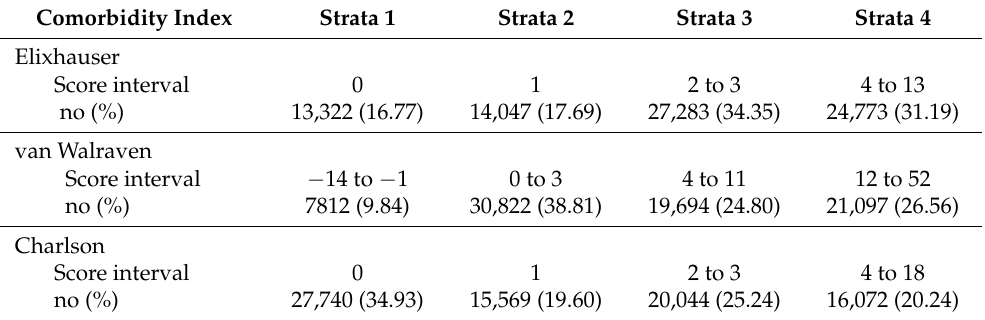
Table 4. Elixhauser, van Walraven and Charlson score interval and frequency of each strata.